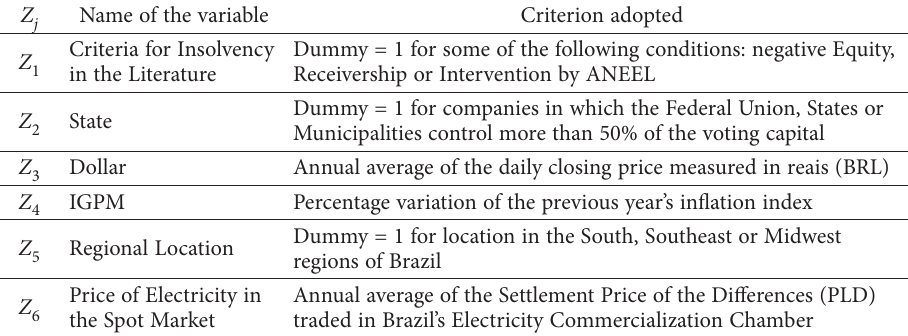
Table 3. Contextual variables